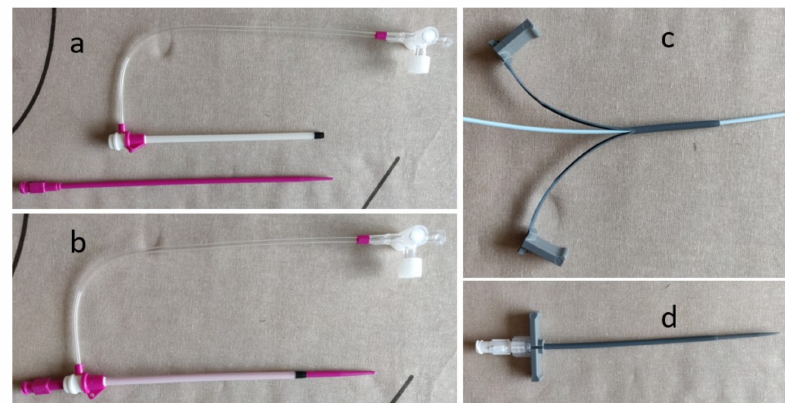
Figure 4. Di ff erent access sheaths. (a) Vascular sheath and inner dilator; (b) Assembled vascular sheath with inner dilator; (c) Peel away sheath partially open with inner introducer; (d) Peel away sheath with inner